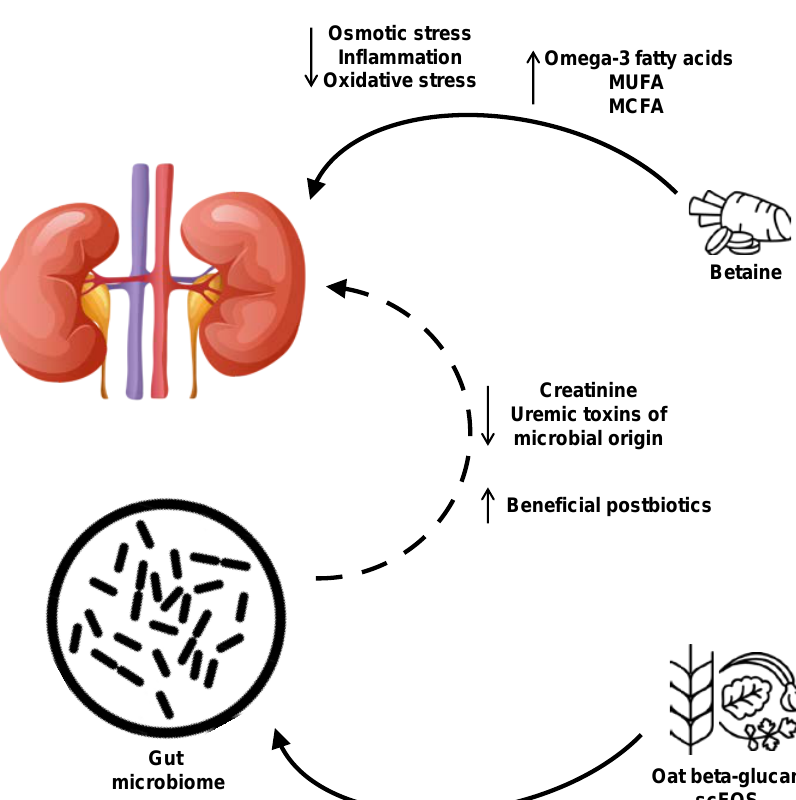
Figure 4. Summary of the effects of the food with added betaine, scFOS, and oat beta-glucan on metabolites and health. Consumption of oat beta-glucan and scFOS results in positive, gut microbiota-mediated changes in the metabolome, while betaine has a more direct effect on kidney health. MCFA, medium-chain fatty acids; MUFA, monounsaturated fatty acids; scFOS, short-chain